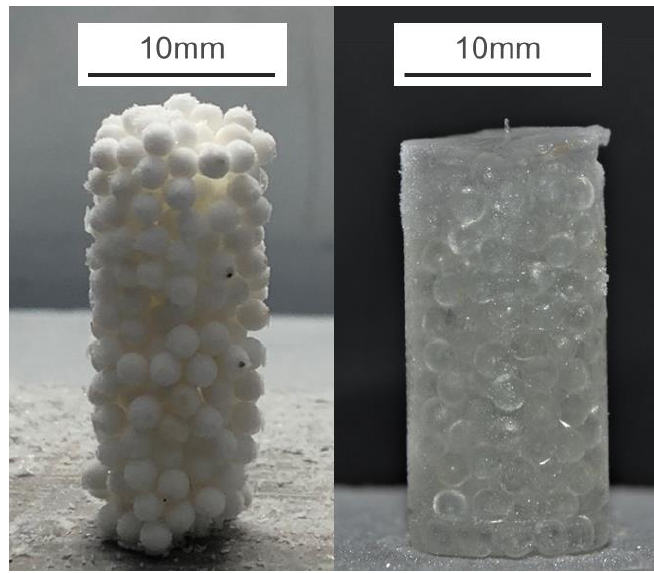
Figure 2. Two exemplary samples of frozen PFS: ( Left ) aggregate with alpha-alumina primary particles at 75% saturation level; ( Right ): glass bead PFS with 100% saturation.